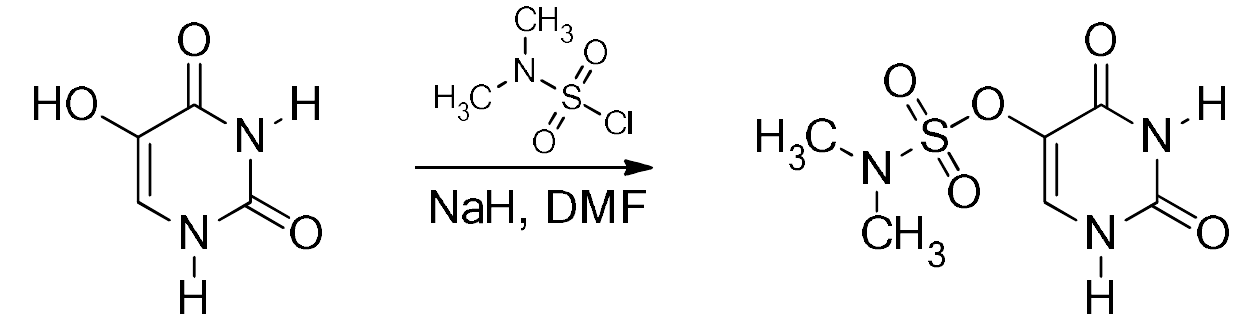
Figure 6. Synthesis of uracil-5-yl O -( N,N -dimethylsulfamate). To a stirred solution of sodium hydride (60% dispersion in oil, 23.4 mg, 0.59 mmol) in anhydrous N,N -dimethylformamide (DMF; 2 mL) at room temperature, 5-hydroxy- uracil (75 mg, 0.58 mmol) was added. The mixture was left in an ultrasonic bath under an